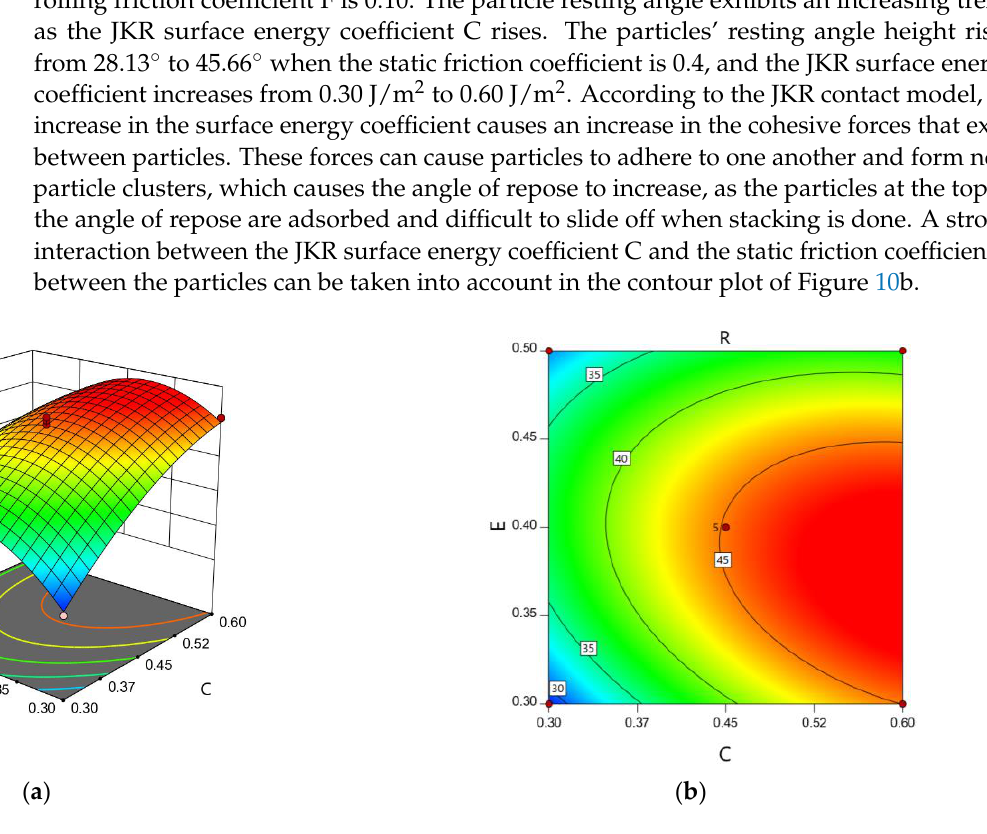
Figure 10. Response surface diagram ( a ) and contour diagram ( b ) of the influence of JKR surface energy coefficient and static friction coefficient on repose angle.